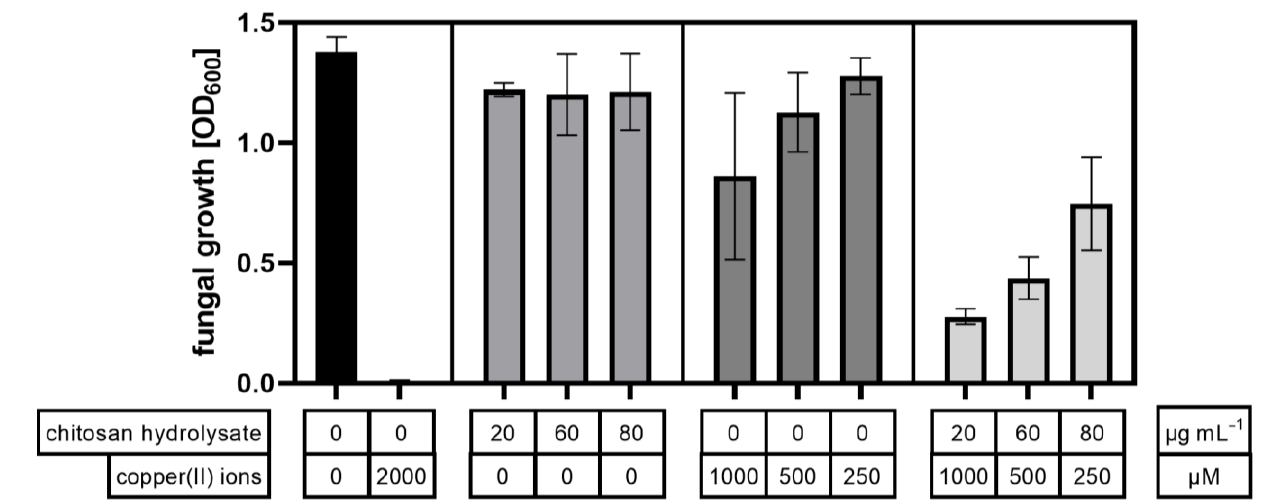
Figure 5. Growth of F. graminearum after 96 h in the presence of combinations of chitosan hydrolysate and copper(II) ions. In addition to the combinations, the individual compounds were tested in concentrations used for the combinations. Water and high copper(II) ion concentration (2000 µM) were used as controls.